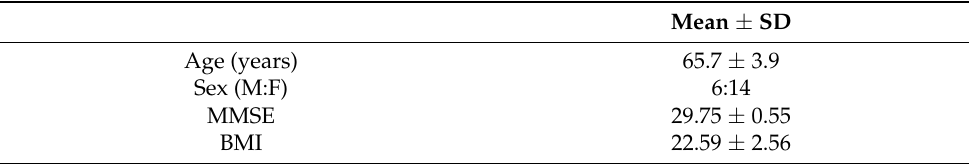
Table 1. Demographics of